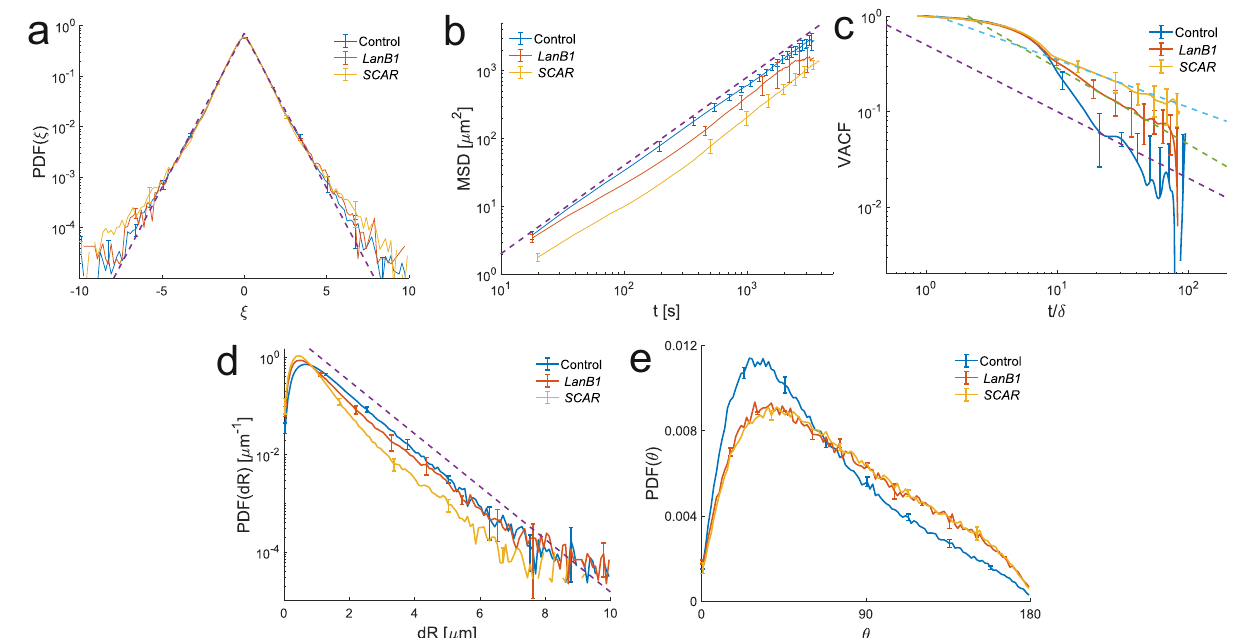
Fig. 3 Hemocytes move via heterogeneous anomalous diffusion. ( a ) Distributions of x-component of displacements, dx = x ( t + τ ) − x ( t ), calculated at the shortest measurement time τ (see Supplementary Note 1) are non-Gaussian and follow the Laplace distribution, PDF ð ξ Þ ¼ exp (cid:3)j ξ j = b dashed line. The dashed-dotted line corresponds to the numerically calculated distribution of displacements of heterogeneous FBM (hFBM) with the Weibull PDF of generalized diffusion coef fi cients and reproduces the experimental distributions of displacements in control, LanB1 and SCAR embryos. ( b ) MSDs as a function of time interval grow superdiffusively with anomalous exponents α = 1.3 ± 0.1. The dashed line represents the power-law functions t 1.3 as a guide. LanB1 and SCAR embryos have progressively more anti-persistent motion on the shortest time scales while their long time behaviour remains superdiffusive. ( c ) Velocity auto-correlation functions as a function of time interval are positive and decay to zero as power-laws, ( t / δ ) α − 2 , with α determined from the MSDs at longer times (see Supplementary Fig. 8) and δ = 10 τ . ( d ) Distributions of incremental displacements dR ¼ calculated for τ time intervals decay exponentially. The dashed line represents an exponential function. ( e ) Distributions of incremental angles θ ¼ arccos ð d r r = j d r r = r − r r = r − r 2 1 and d 2 3 2 are displacement vectors (see the inset in Fig. 2b). In contrast to Fig. 2b, c, here we do 1 (cid:2) d 2 1 jj d 2 jÞ , where d r 1 separate persistent and anti-persistent periods of motion. Statistical quantities in this fi gure were averaged over 4 data sets of control, LanB1 and SCAR embryos. The error bars correspond to standard error of the